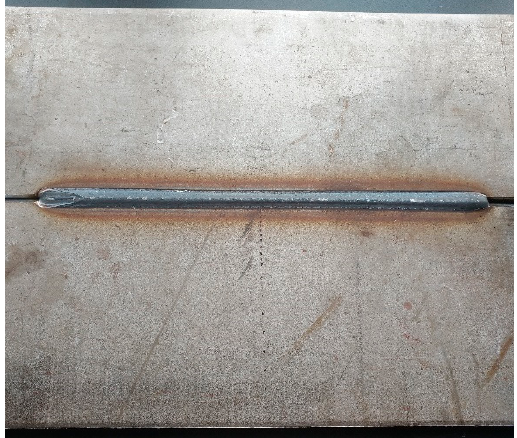
Figure 1. View of T4003 stainless steel welded joint.